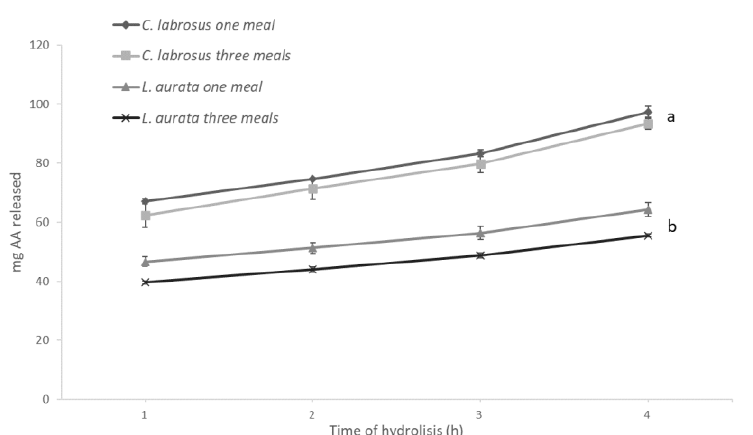
Figure 2. Release of amino acids (AA) from L. aurata and C. labrosus when simulating the different feeding frequencies in vitro (n = 18). Data expressed as means ± SD. Significant differences between species ( p < 0.05) are indicated using lowercase letters (a, b).